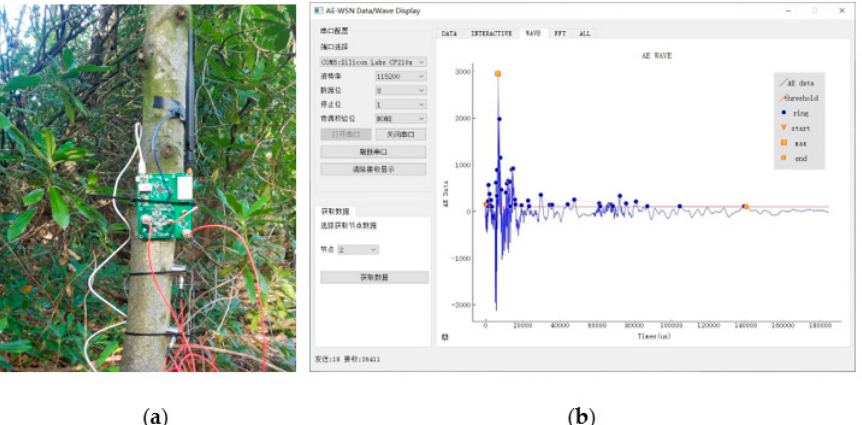
Figure 5. Actual sensor node installation and data collection diagram: ( a ) deployment of AE nodes and ( b ) display interface of AE data.